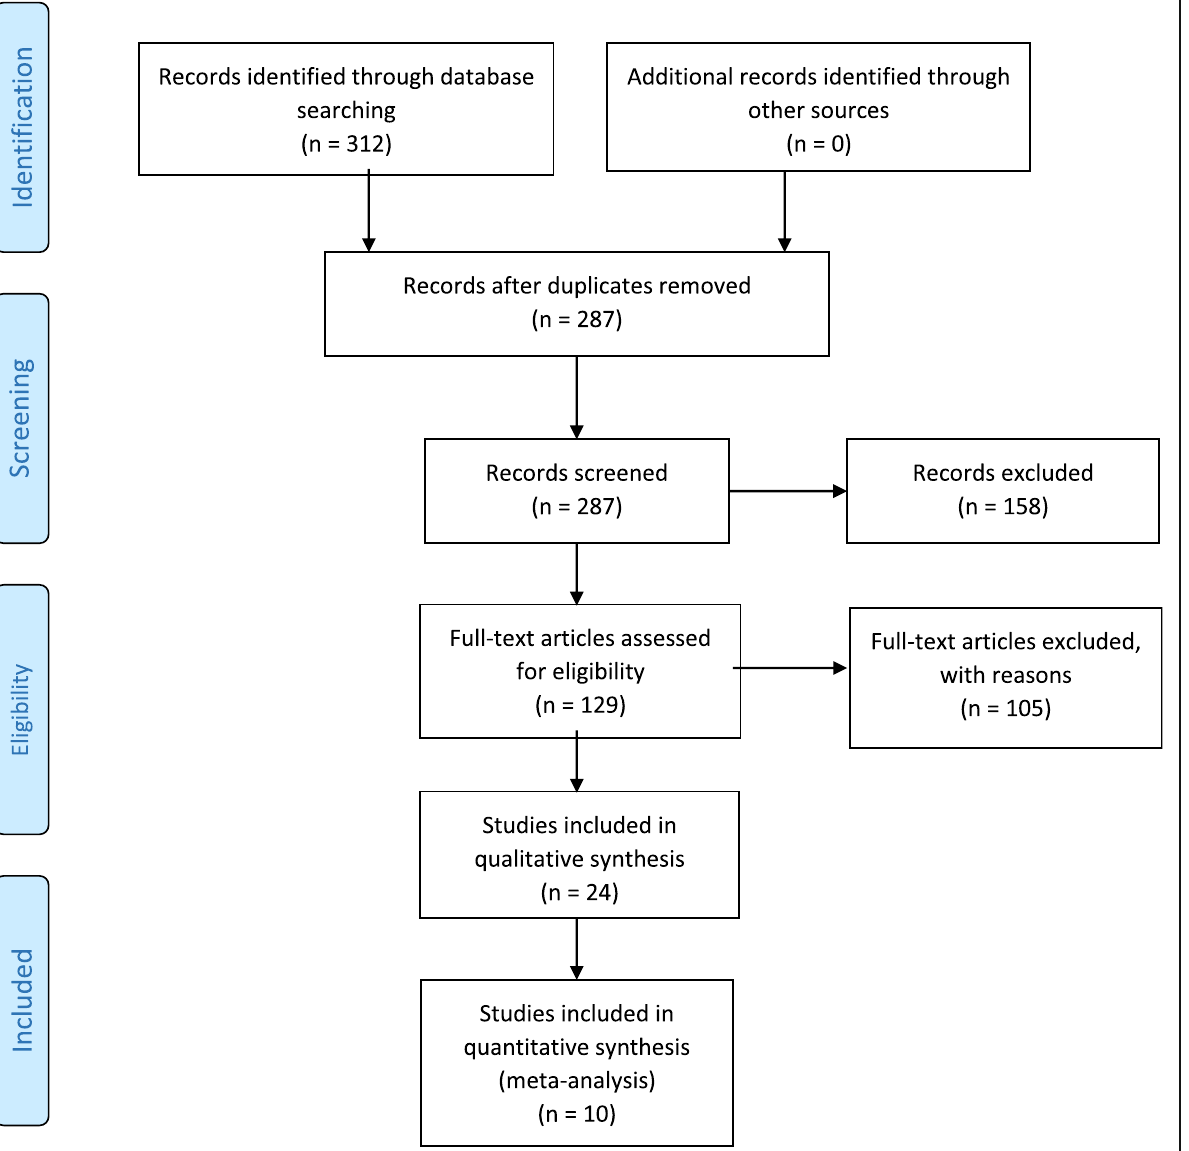
Fig. 1 PRISMA flow diagram of the process of study selection for the systematic review